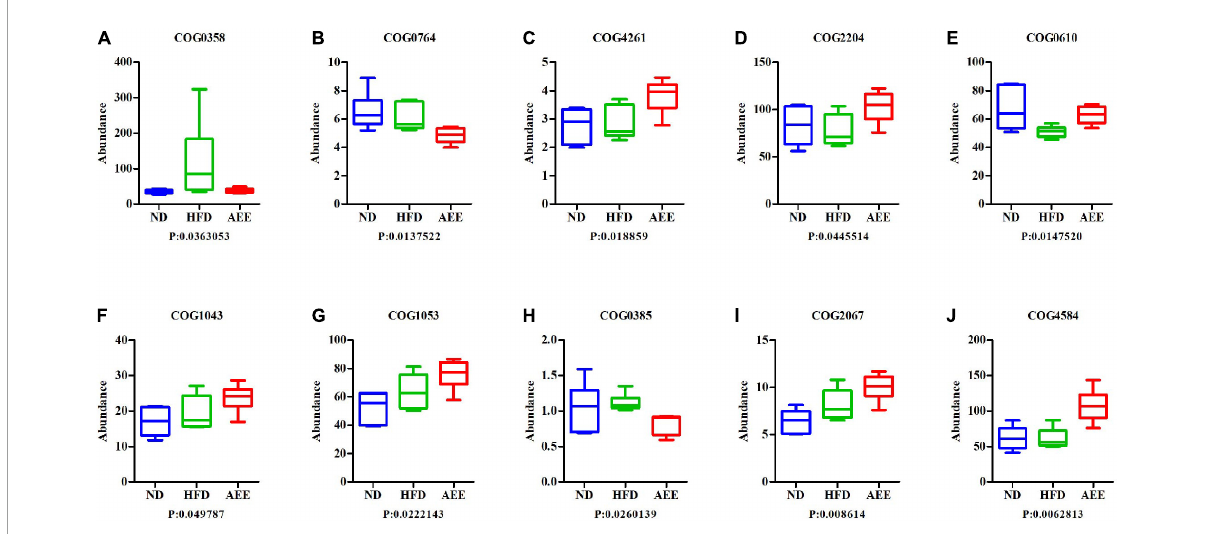
FIGURE10 The significant difference functions in eggNOG. (A–J) The significant difference functions in eggNOG are DNA primase activity, unsaturated fatty acids biosynthesis, lipid A biosynthesis acyltransferase, two component, sigma 54 specific, transcriptional regulator, fis family, type site-specific deoxyribonuclease, the biosynthesis of lipid A, succinate dehydrogenase, bile acid, lipid transport and transposase. The horizontal axis is the sample grouping; Vertical is the relative abundance of the corresponding function. P < 0.05 indicated significant difference between the two groups, and P < 0.01 indicated extremely significant difference between the two